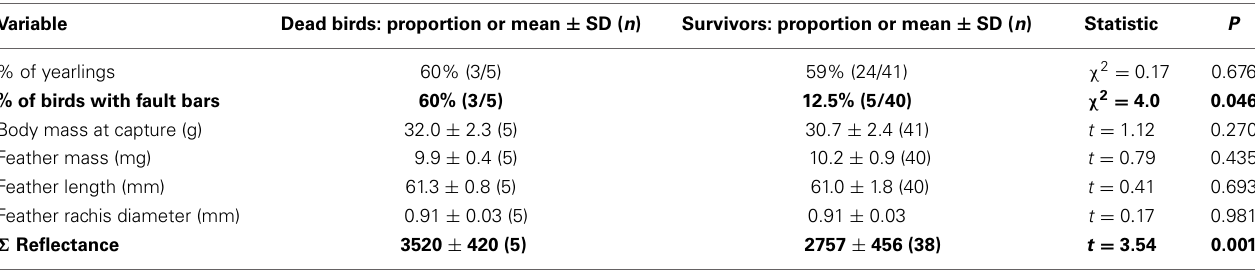
FIGURE 1 | (A) Reflectance spectra of tail feathers of female greenfinches surviving (gray lines) and dying (black lines) in the outbreak of trichomonosis. (B) Palest and darkest extremes of Table 1 | Comparison of greenfinches that did and did not survive trichomonosis outbreak. Variable Dead birds: proportion or mean ± SD ( n ) Survivors: proportion or mean ± SD ( n )